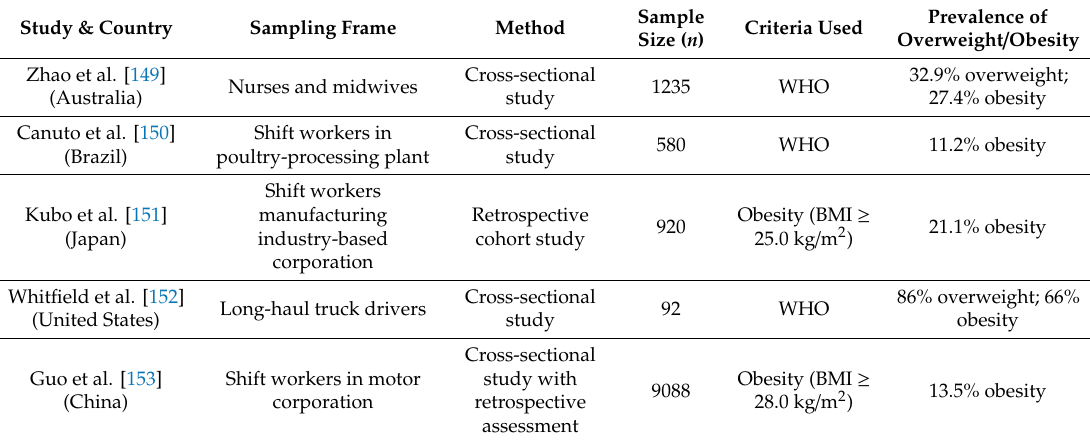
Table 2. Prevalence of overweight and obesity in workers from di ff erent parts of the